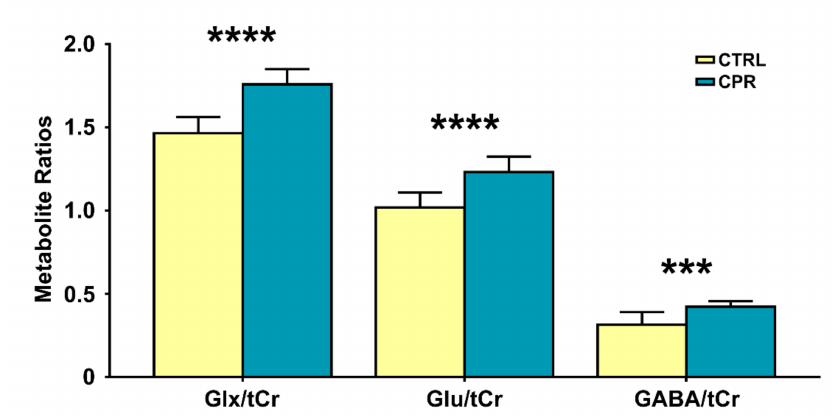
Figure 4. Bar graph showing the mean cerebral metabolite ratios in the right hippocampal region of the control (CTRL) and cuprizone-treated (CPR) rats. The vertical lines on each of the bars indicate the (+) standard deviation of the mean values. *** p < 0.005; **** p < 0.001. GABA, gamma-aminobutyric acid; Glx, Glu (glutamate) + Gln (glutamine); tCr (total Cr), Cr (creatine) + PCr